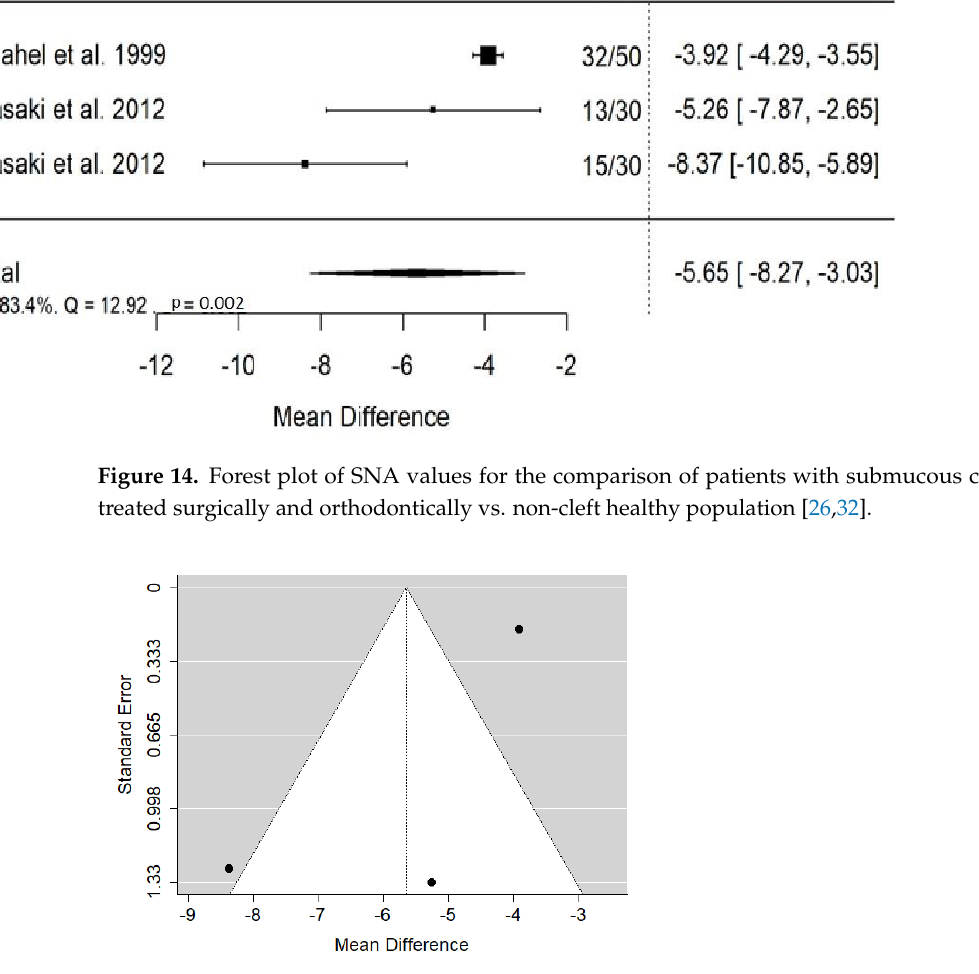
Figure 15. Funnel plot of SNA values for the comparison of patients with submucous cleft palate treated surgically and orthodontically vs. non-cleft healthy population [26,32]. ANB